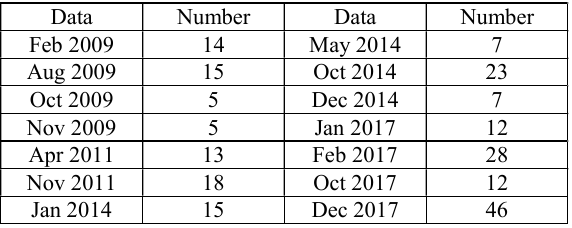
Table 1. Measured data